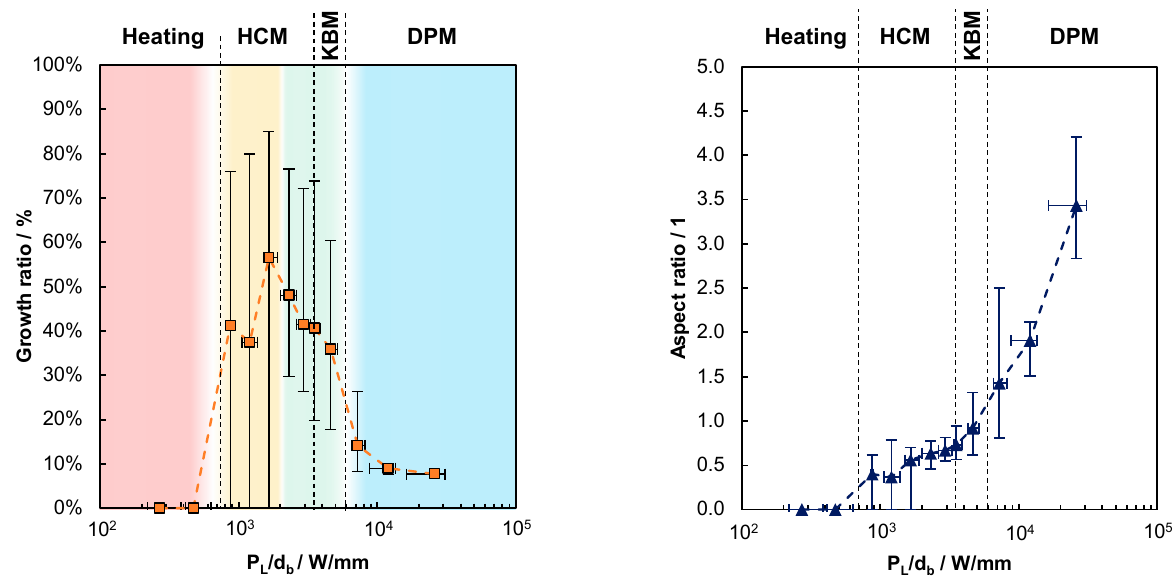
Figure 8. ( Left ) growth ratio A a / A tot as function of P L / d b with the corresponding processing modes. Red-colored area: complete failure of the additive process with η P = 0. Yellow-colored area: occasional failure of the additive process with minimum values of the error bars at 0% of η P . Green-colored area: reproducible additive process with efficiencies always >0% in all experiments. Blue-colored area: reproducible additive process with average efficiencies <5%, but always >0%. ( Right ) aspect ratio depth/width of the bead as a function of P L / d b with the corresponding processing